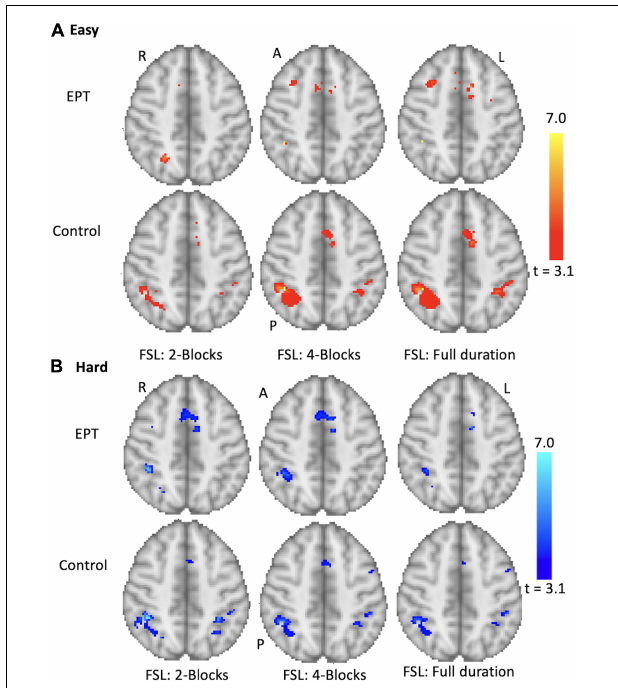
FIGURE 9 | Group results for the 1-back task. Analysis performed for control and EPT subjects using FSL. Early stopping with 2- and 4-blocks being initially administered is compared to full duration. Activations are overlaid on the MNI template brain. Red (A) = easy level results, Blue (B) hard level results. Group results thresholded at z = 3.10 ( p < 0.001). Slice z = 59 is shown. R = right, L = left, A = anterior, P =